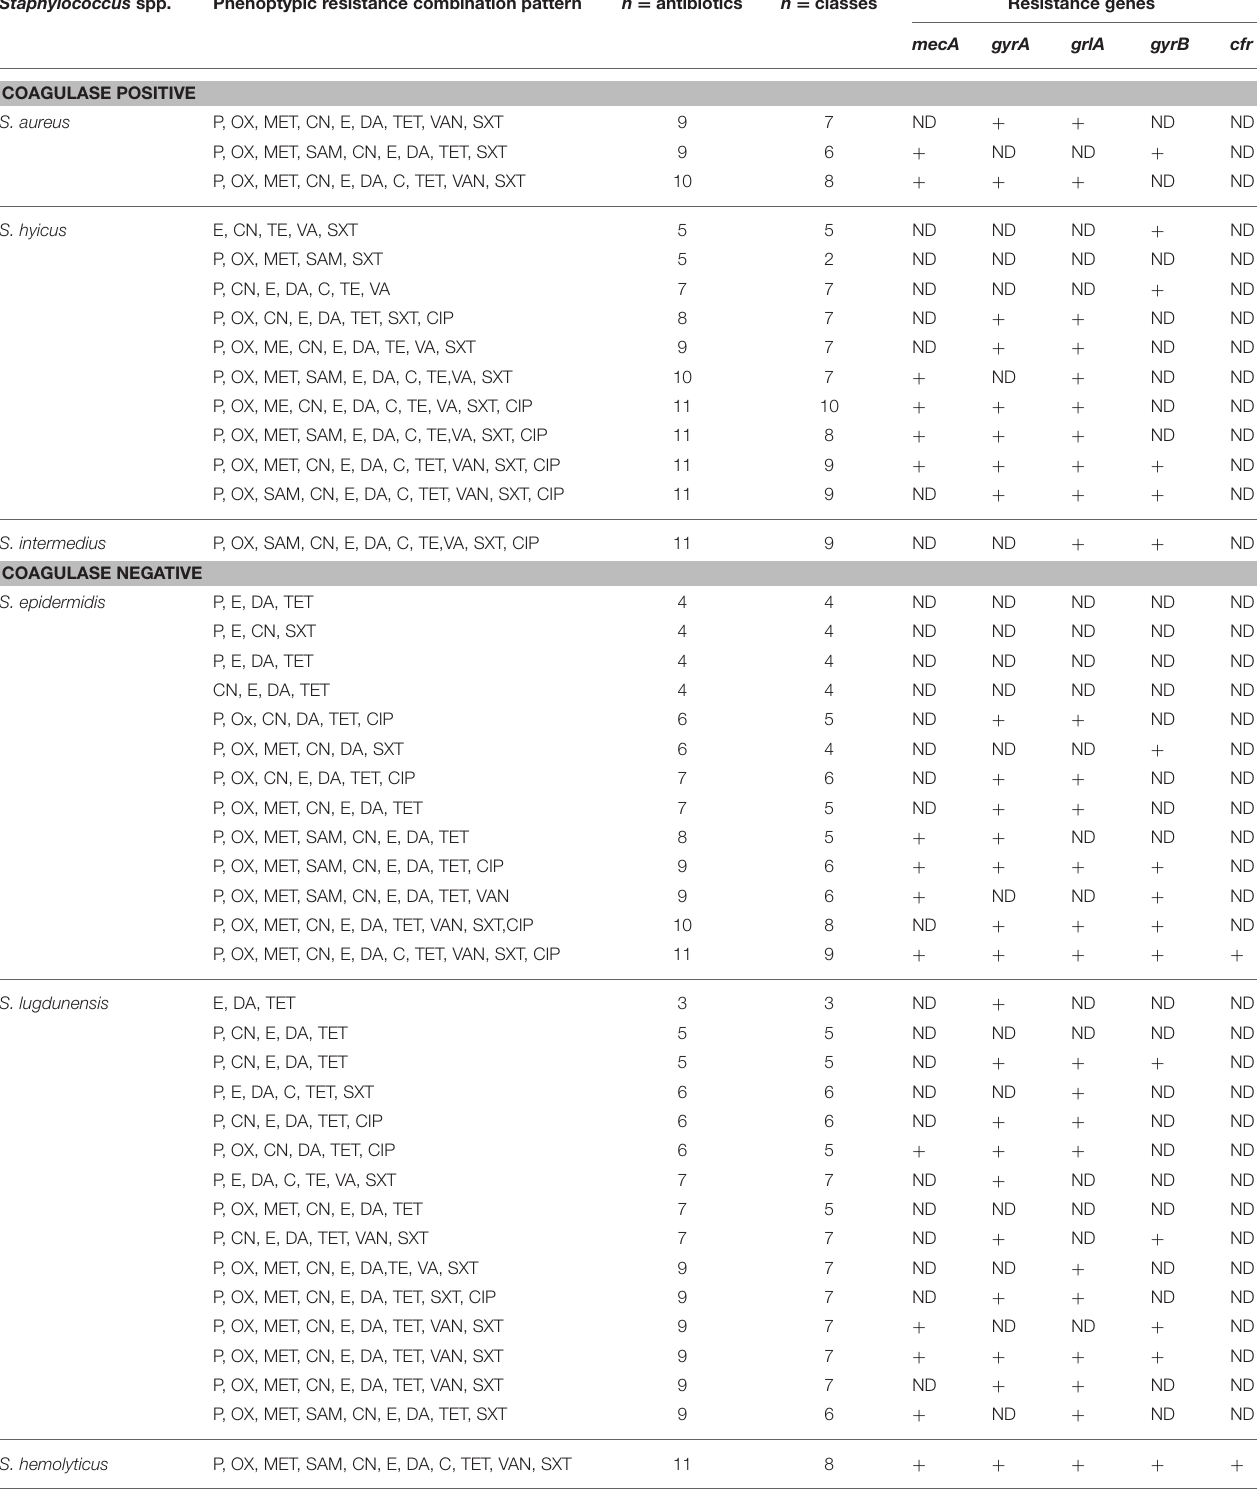
TABLE 4 | Multidrug resistance profiles and resistance genes of CPS and CNS from chicken meat. Staphylococcus